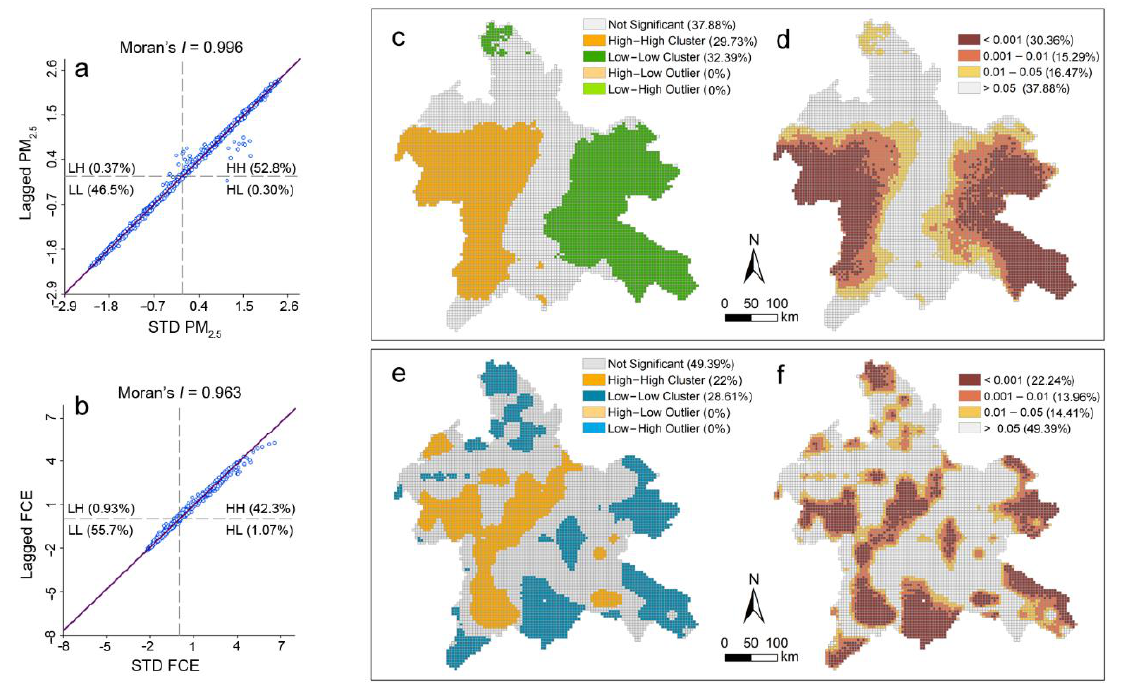
Figure 2. Spatial distribution pattern of PM 2.5 concentration and FCE in the study area based on cluster and outlier analysis (Ansel in local Moran’s I ). ( a , b ) Moran’s I scatter plot of PM 2.5 concentration and FCE in NL, respectively. The abscissa is the observed value of PM 2.5 concentration and FCE of a spatial unit (after standardization), while the ordinate is the “ lagged ” value of the spatial unit, i.e., the average value of the observed PM 2.5 concentration and FCE of adjacent units (after standardization); ( c , e ) LISA agglomeration of PM 2.5 concentration and FCE in study areas; ( d , f ) distribution of areas significant or not for LISA agglomeration. Table 2. The summary statistics of the variables for the studied region. Note: FCE is the fire carbon emission, AI is the aridity index, TMP is the annual average temperature at 2 m, DTR is the average daily temperature range, LAI is the vegetation leaf area index, and SM is the soil moisture.